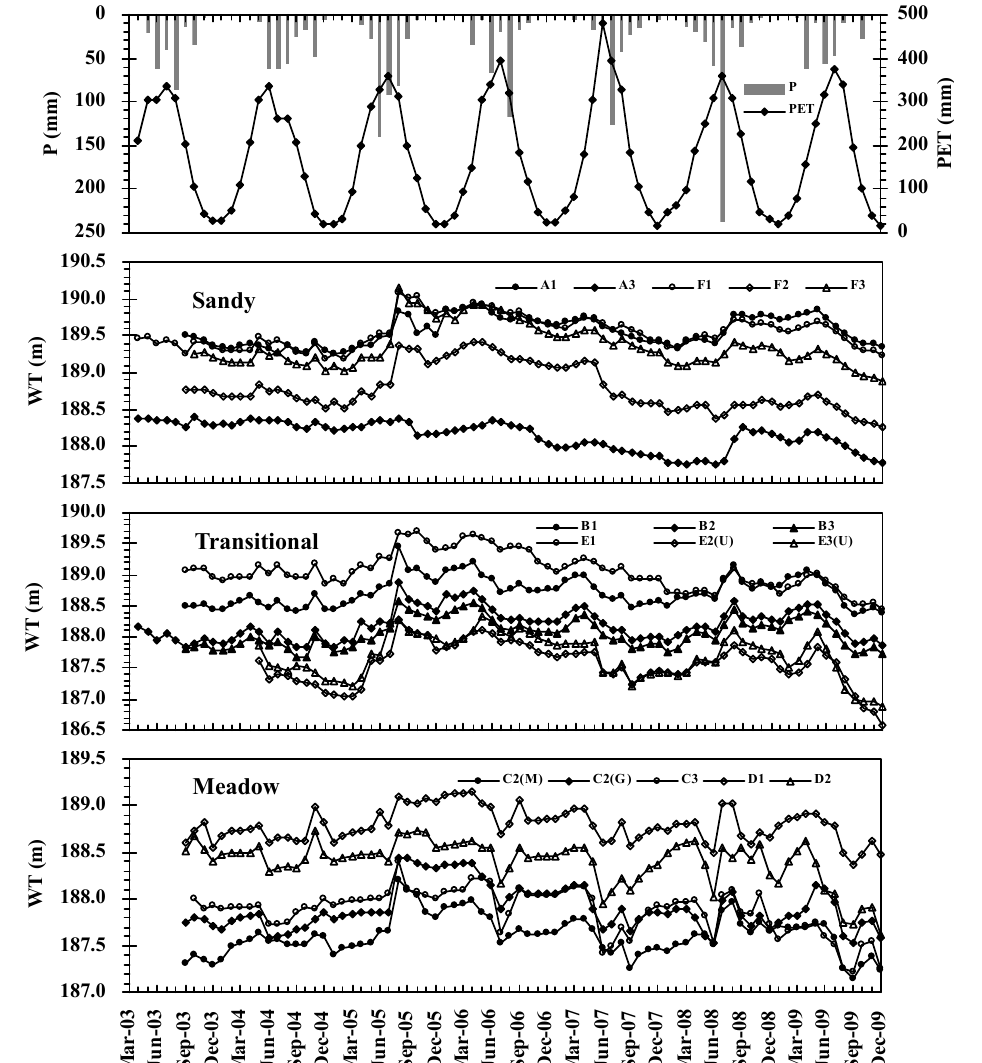
Figure 4. Responses of mean monthly water table (WT) to cumulative monthly precipitation (P) and potential evapotranspiration (PET) for the three land cover types in the study area. The average ground elevation is 212.0 m for the sandy areas (Sandy), 190.0 m for the transitional zones (Transitional), and 188.5 m for the meadowlands